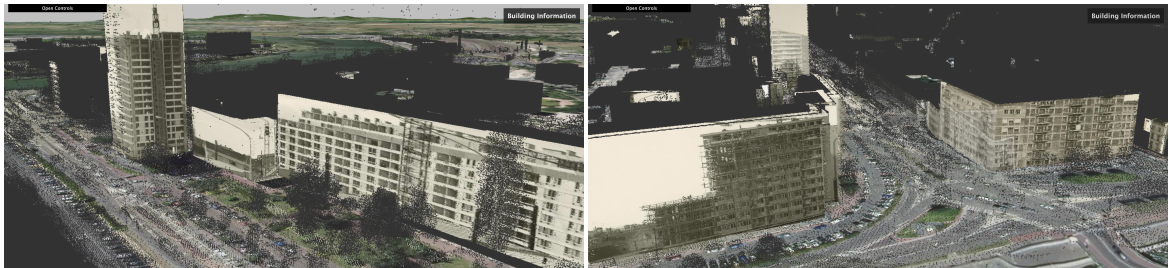
Figure 2. Current 3D city and terrain model and mobile mapping point cloud textured on the fly in real-time using historical images.